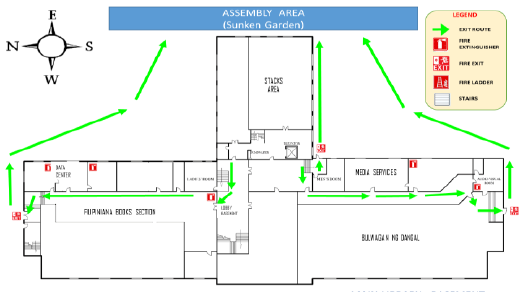
Figure 13. Generated Evacuation Ground Floor Routes